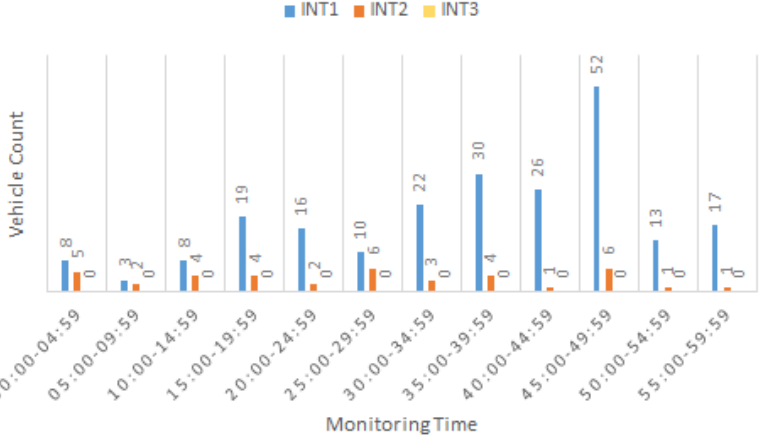
Figure 8. Branch-right (BR) count estimation in 5-min